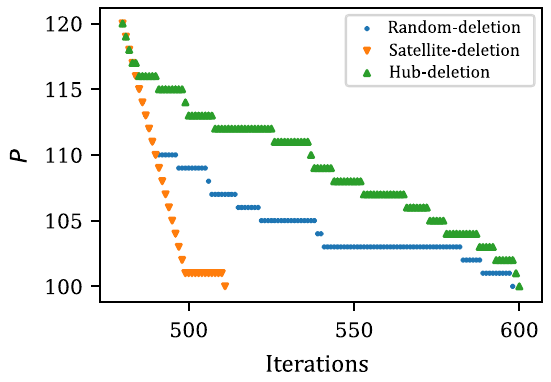
FIG. 10. The greedy algorithm for optimal sensor node selec- tion for invertibility applied to a network with N ¼ 1000 state nodes and M ¼ 100 randomly distributed inputs. From the remaining 900 nodes, the maximum output set Z 0 with P 0 ¼ 700 potential sensor nodes is randomly chosen. The plot compares the number of sensor nodes P versus the number of iterations of the greedy algorithm for random-, satellite-, and hub- deletion